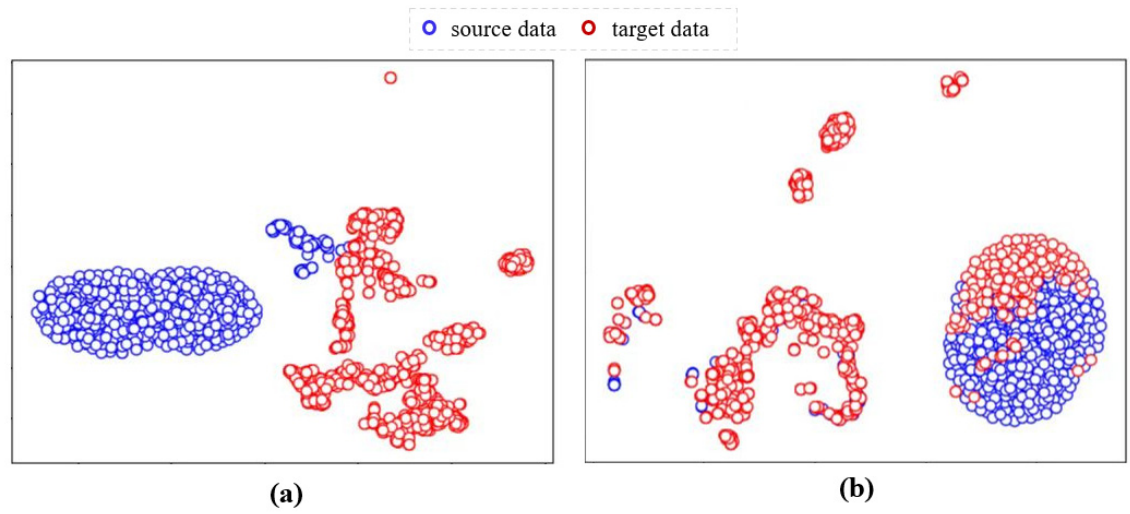
Figure 9. ( a ) Original data distribution of source and target datasets. ( b ) Data distribution of source and target datasets after data adaptation module.